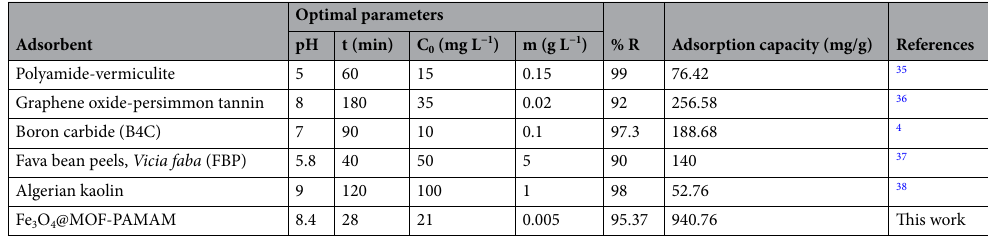
Table 7. Comparison of adsorption of MB with other